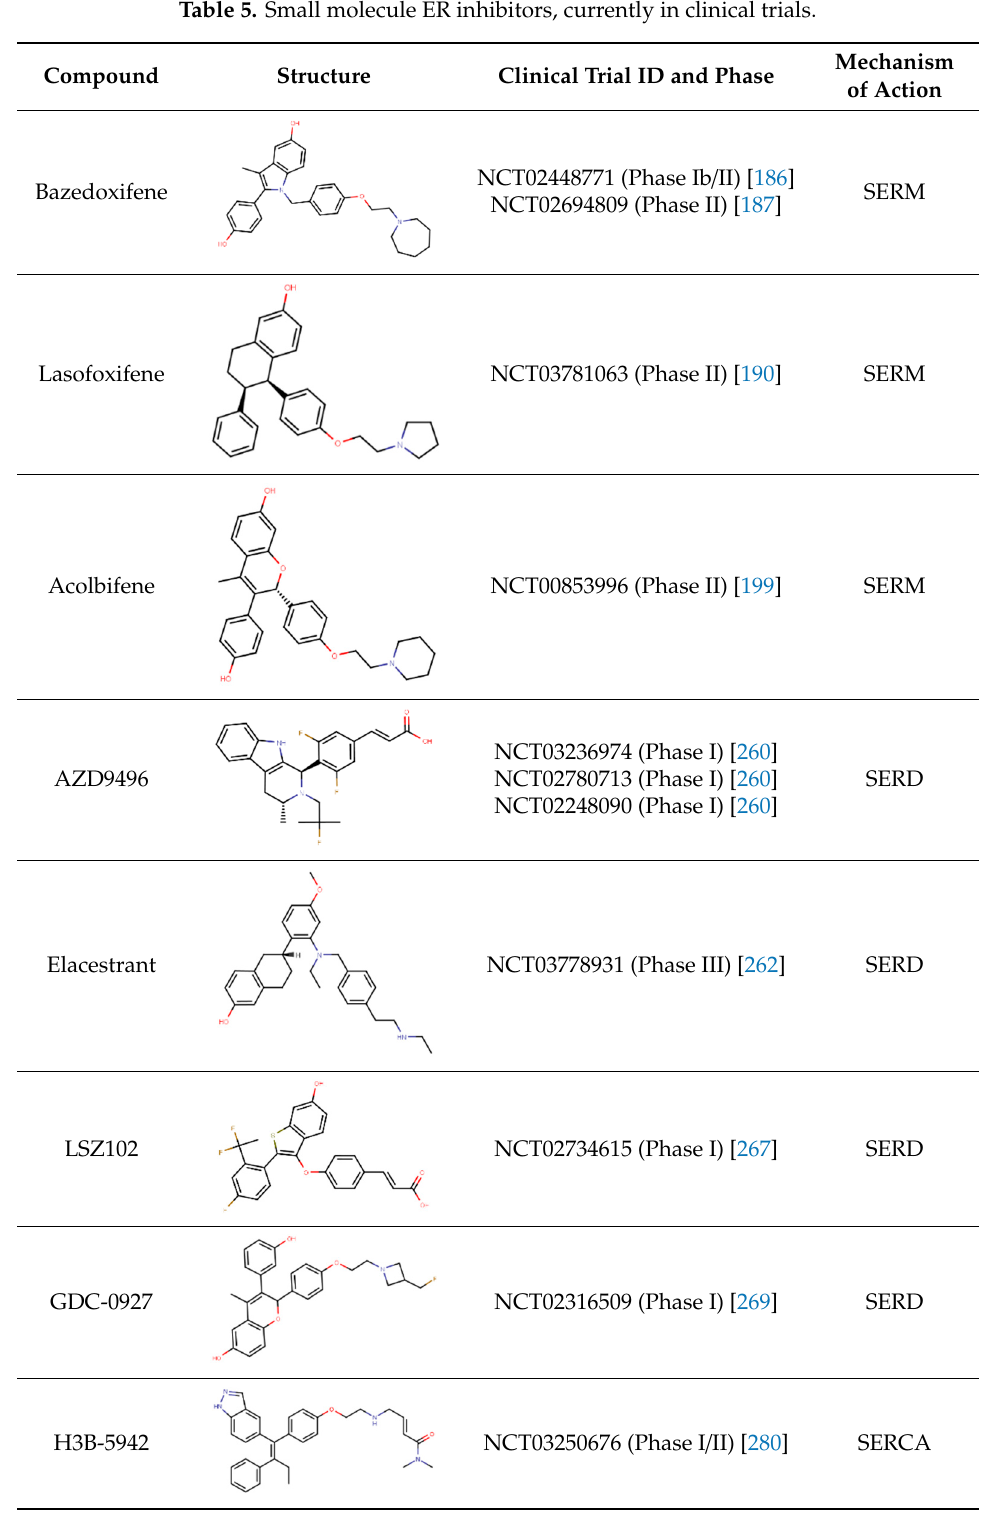
Table 5. Small molecule ER inhibitors , currently in clinical trials.